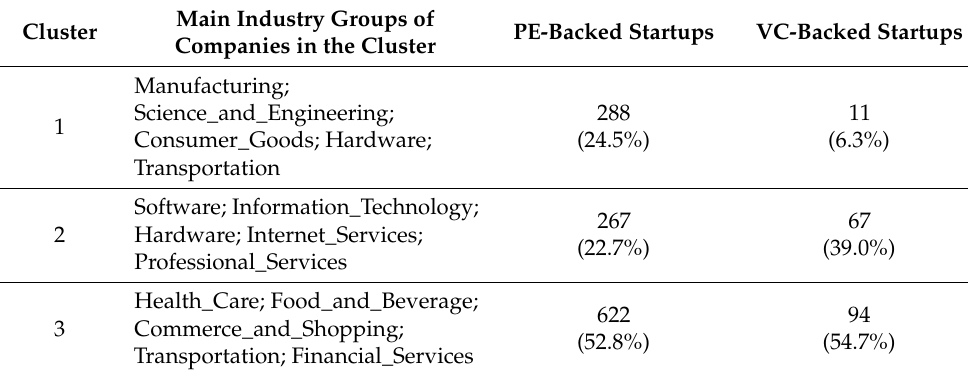
Table 3. Later Stage Companies by Cluster and Funding Type. Cluster